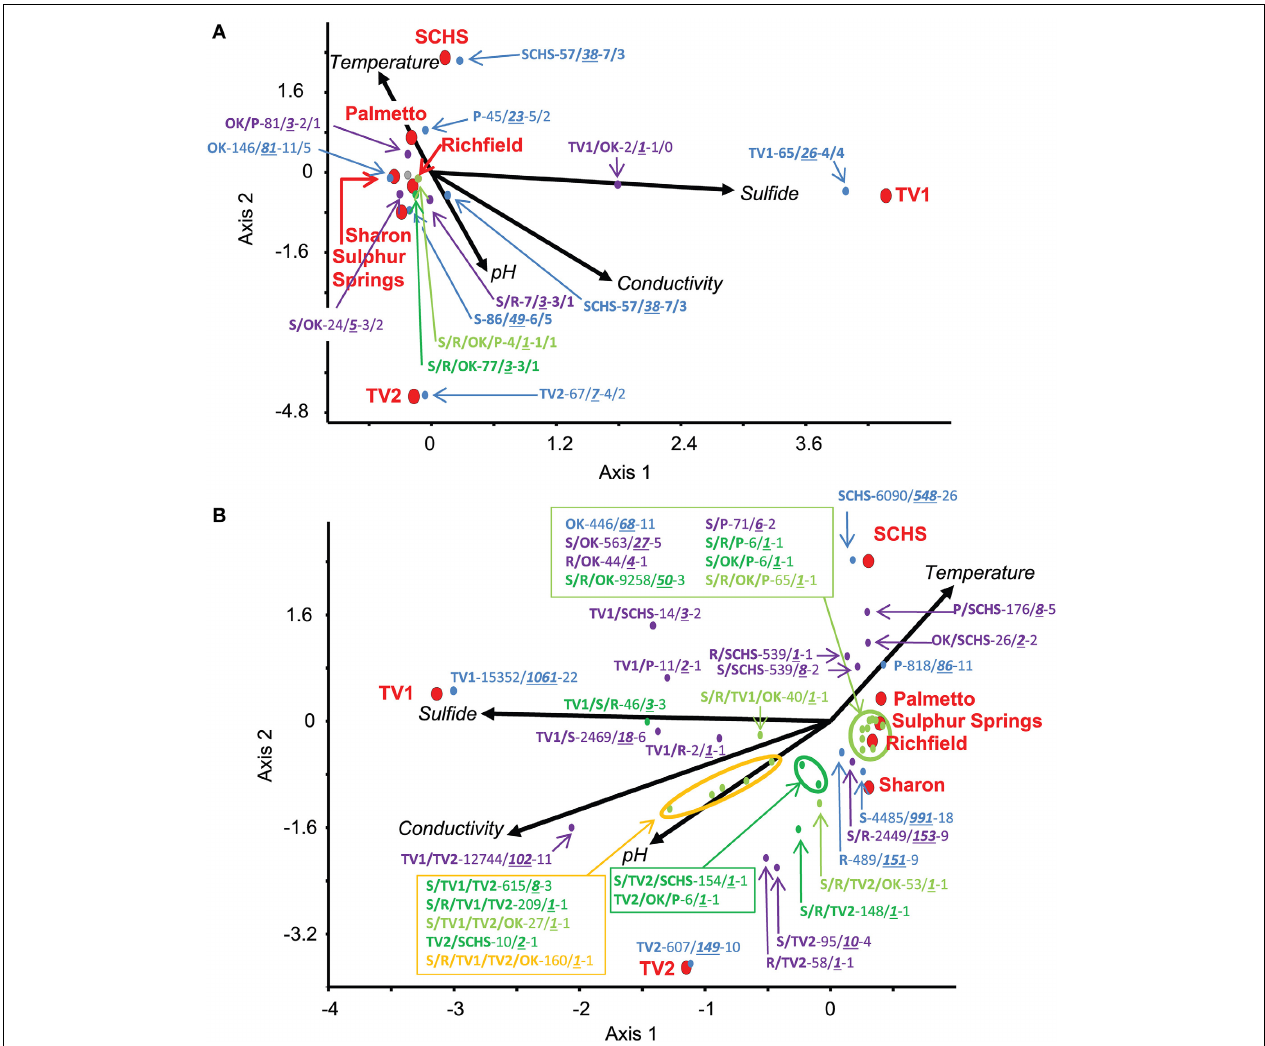
FIGURE 3 | Canonical Correspondence Analysis (CCA) for the study springs,abbreviatedasSharon(S),SharonSprings;Richfield(R),Richfield Springs; TV1, Tully Valley 1; TV2, Tully Valley 2; OK, Sulphur Springs; Palmetto(P),PalmettoSprings;SCHS,SouthCanyonHotSprings.(A) CCA of OTUs of near-full length 16S rRNA gene sequences produced from Sanger sequencing ( P -value = 0.02). Red dots represent the sampled springs. Colored dotsrepresentOTUscomprisedofdifferentnumbersofspringsthatarelabeled